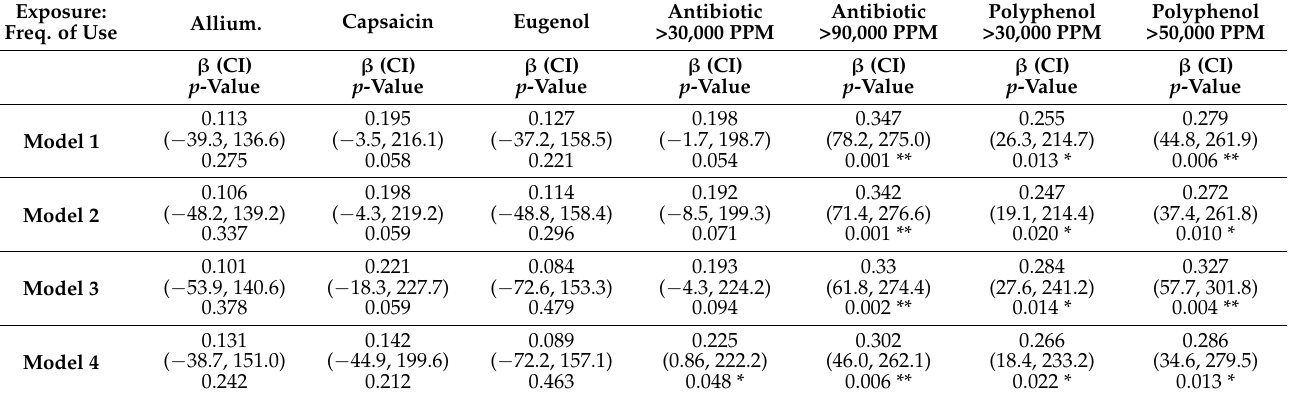
Shown are the beta coefficients and p -values associated with each regression model. Model 1: Exposure variable (frequency of culinary herb use); Model 2: Model 1 + Demographic factors; Model 3: Model 2 + Dietary factors;